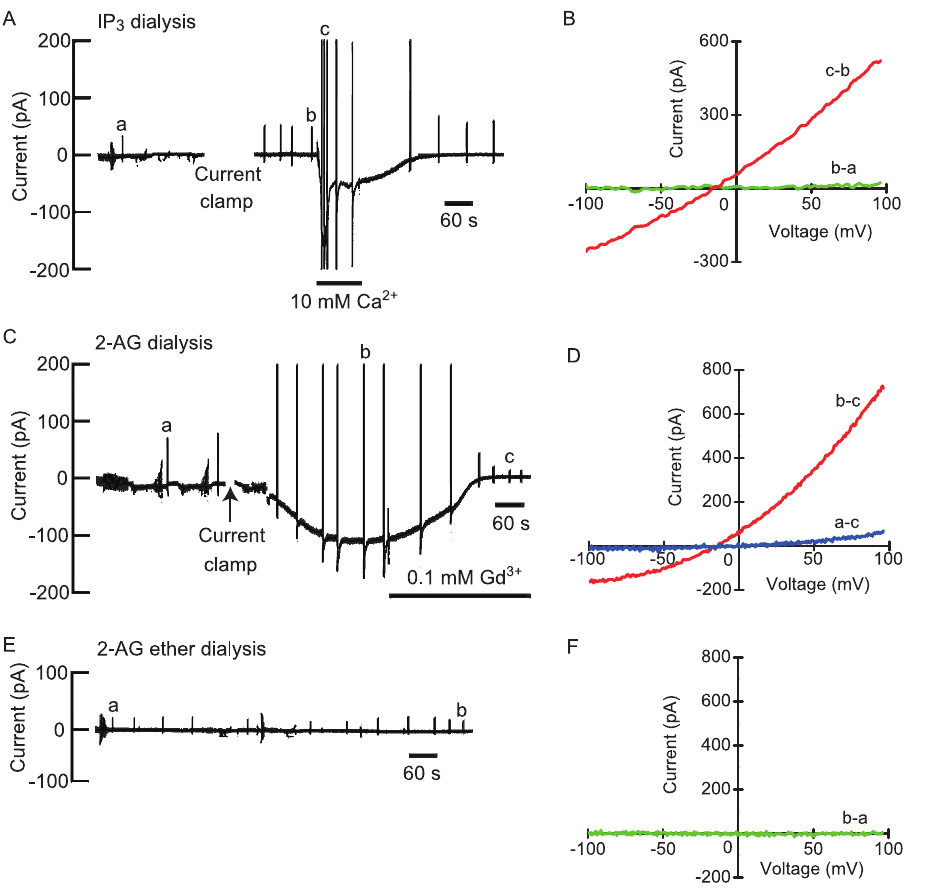
Figure 5. Effects of intracellular 1,4,5-IP 3 , 2-AG and 2-AG ether. (A),(C),(E) The pen recordings of the current signals measured at 2 54 mV during 50 m M IP 3 dialysis, 50 m M 2-AG dialysis and 50 m M 2-AG ether dialysis. (B),(D),(F) The plots of the whole-cell current/voltage ( I/V ) relationships produced by a voltage ramp. I/V relationships were obtained from the pen recordings on the left. The breaks in the pen recordings denote the condition of current clamp mode.